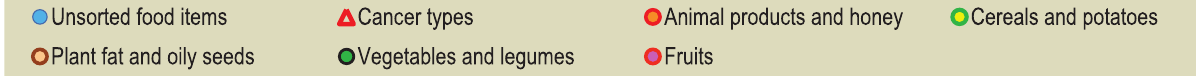
FigUre 9 | Factor analysis: a plot of Factor 1 and Factor 3 explaining 44.2% variability. For better clarity, only the main indicators of cancer incidence were selected (103 variables total). Abbreviations: NHL, non-Hodgkin lymphoma; % PC CARB energy, the proportion of energy from potato and cereal carbohydrates (as % of total energy intake); % CA energy, the proportion of energy from carbohydrates and alcoholic beverages (as % of total energy intake); Protein index, the ratio between milk and wheat proteins (an indicator of a high dietary protein